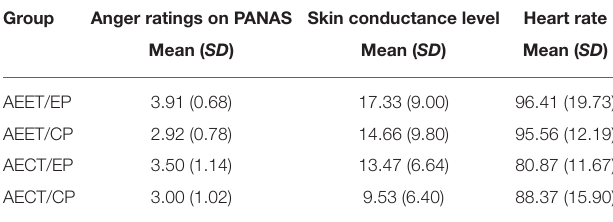
TABLE 1 | Means and standard deviations for all the dependent variables after the anger provocation.